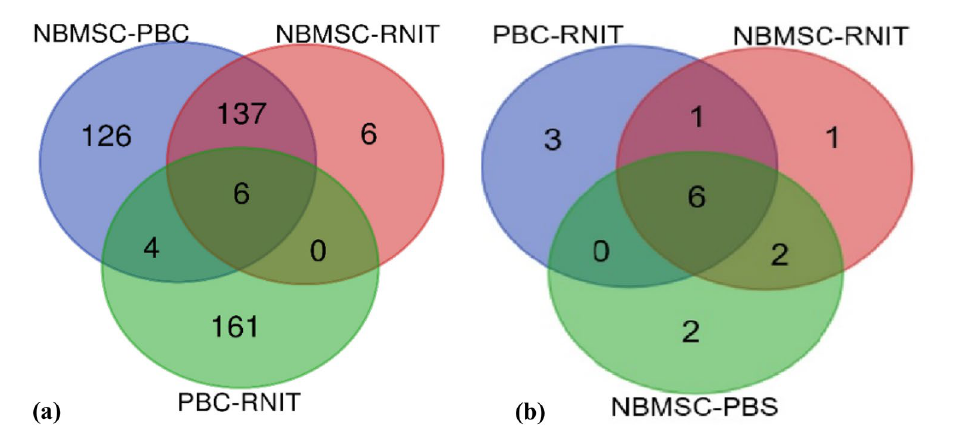
Figure 4. Venn diagram for the obtained genes and miRNAs. ( a ) Venn diagram of genes ( b ) Venn diagram of miRNAs. The webtool (https:// bioin forma tics. psb. ugent. be/ webto ols/ Venn) was used to construct Venn